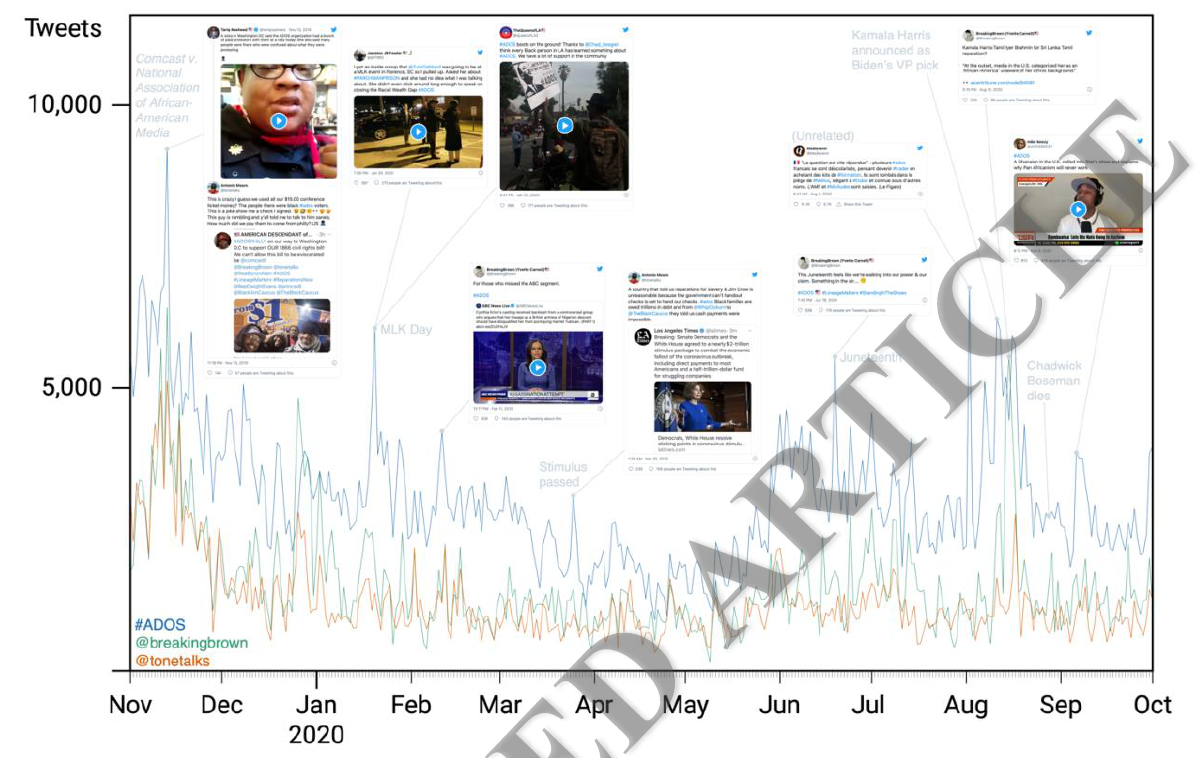
Figure 1. A time series of the daily frequency of tweets in the sample set. Pictured are tweets specifically using the #ADOS hashtag, tweets from/mentioning/retweeting Yvette Carnell (@breakingbrown), and tweets from/mentioning/retweeting Tone Moore (@tonetalks). Also included are some tweets illustrating spikes in activity around real-world